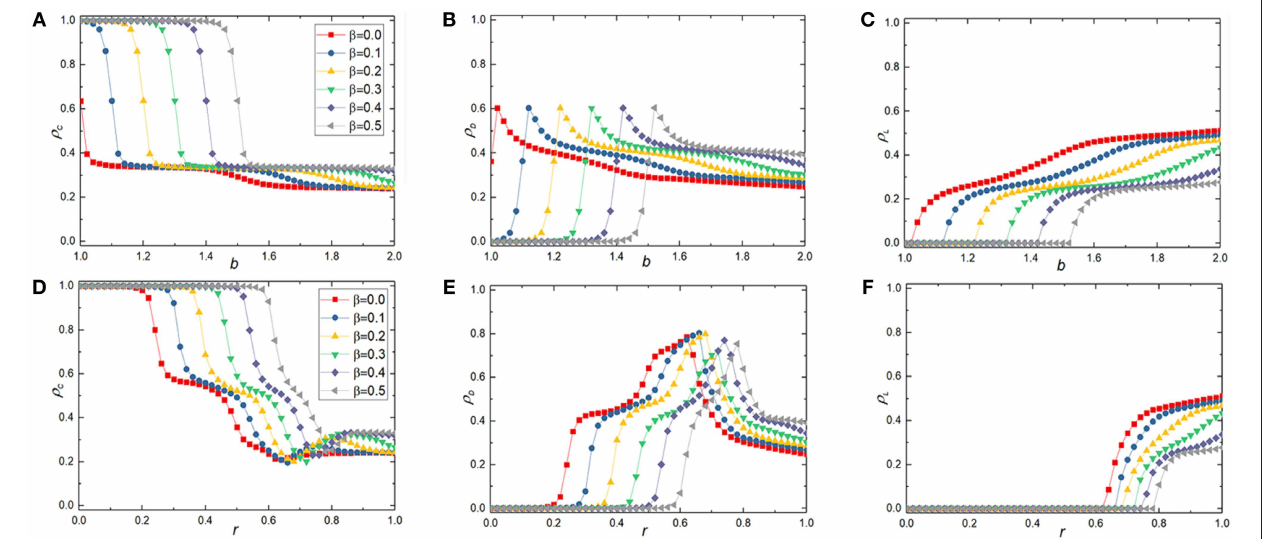
FIGURE 1 | Average frequency of cooperators( ρ C ), defectors( ρ D ), loners( ρ L ) at the stationary sate in dependence on b in the voluntary PDG or r in the voluntary SDG at different reciprocal rewarding strength β on the square lattice. In the top panels [from (A–C) ], the simulation results are acquired in the voluntary PDG, while for the bottom panels [from (D–F) ], results are obtained in voluntary SDG. In all simulations, other parameters are set to be L = 100, MCS = 5 × 10 4 , σ = 0.3, K = 0.1.